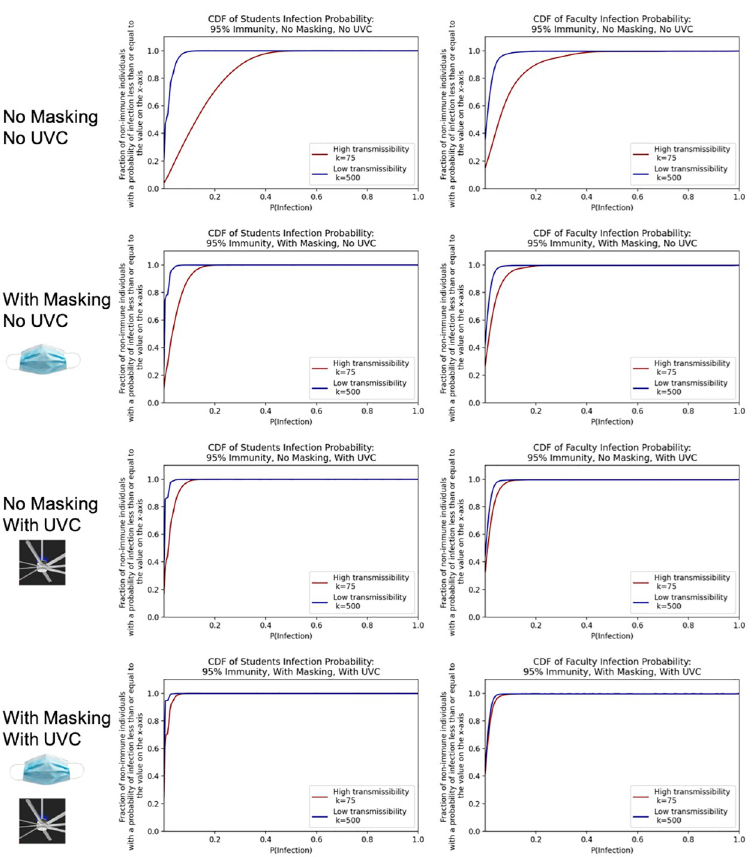
Fig 4. Cumulative density functions over the probabilities of individual student and faculty infection given 95% immunity in the college.